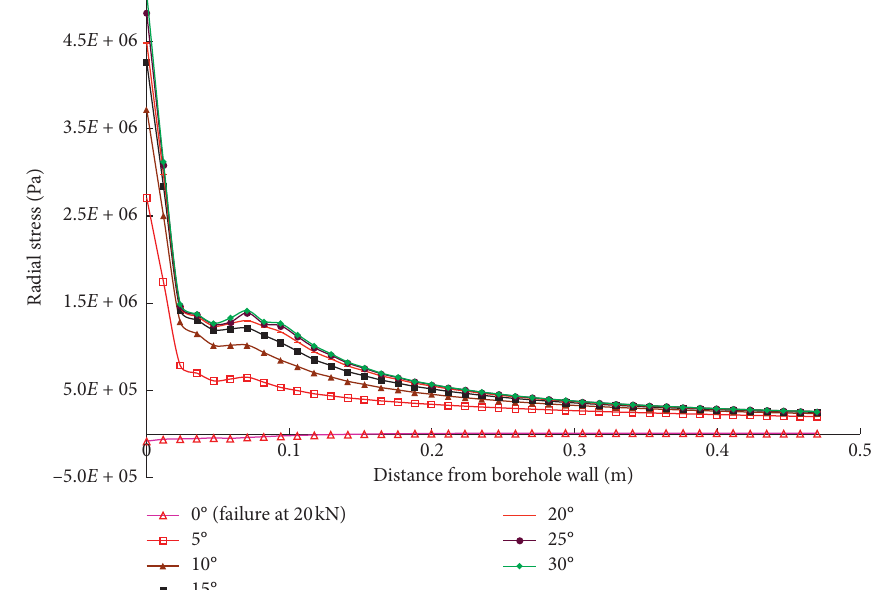
Figure 16: Curves of the radial stress under different dilatancy angles.